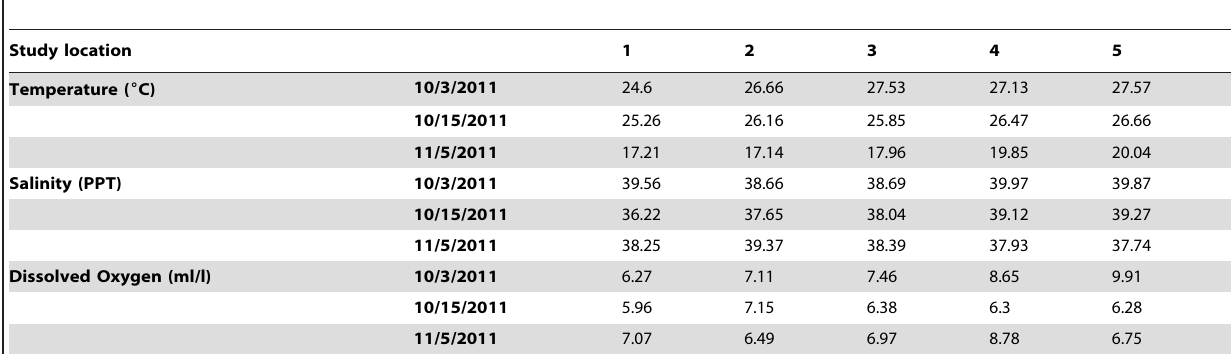
Table 2. Point estimates of temperature, salinity, and dissolved oxygen at each study location by date in Redfish Bay, TX, USA in fall of